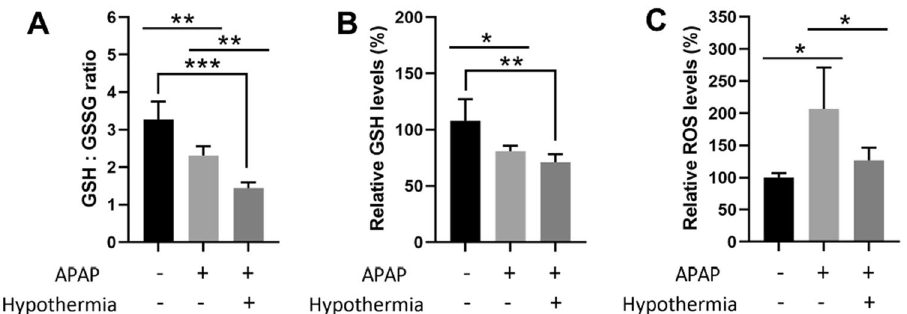
Figure 8. Effect of pulsed cooling on glutathione homeostasis and oxidative stress. ( A ) GSH/GSSG ratio and ( B ) relative GSH levels were determined to examine the flux of GSH recycling and GSH changes respectively. ( C ) The extent of oxidative stress was also inquired by measuring the ROS levels. Data are presented as mean ± SD (n ≥ 3) where one-way ANOVA was used to make comparison across different treatment groups and post-hoc tests were subsequently carried out with correction for multiple comparisons using Sidak’s method. * P < 0.05; ** P < 0.01; *** P <